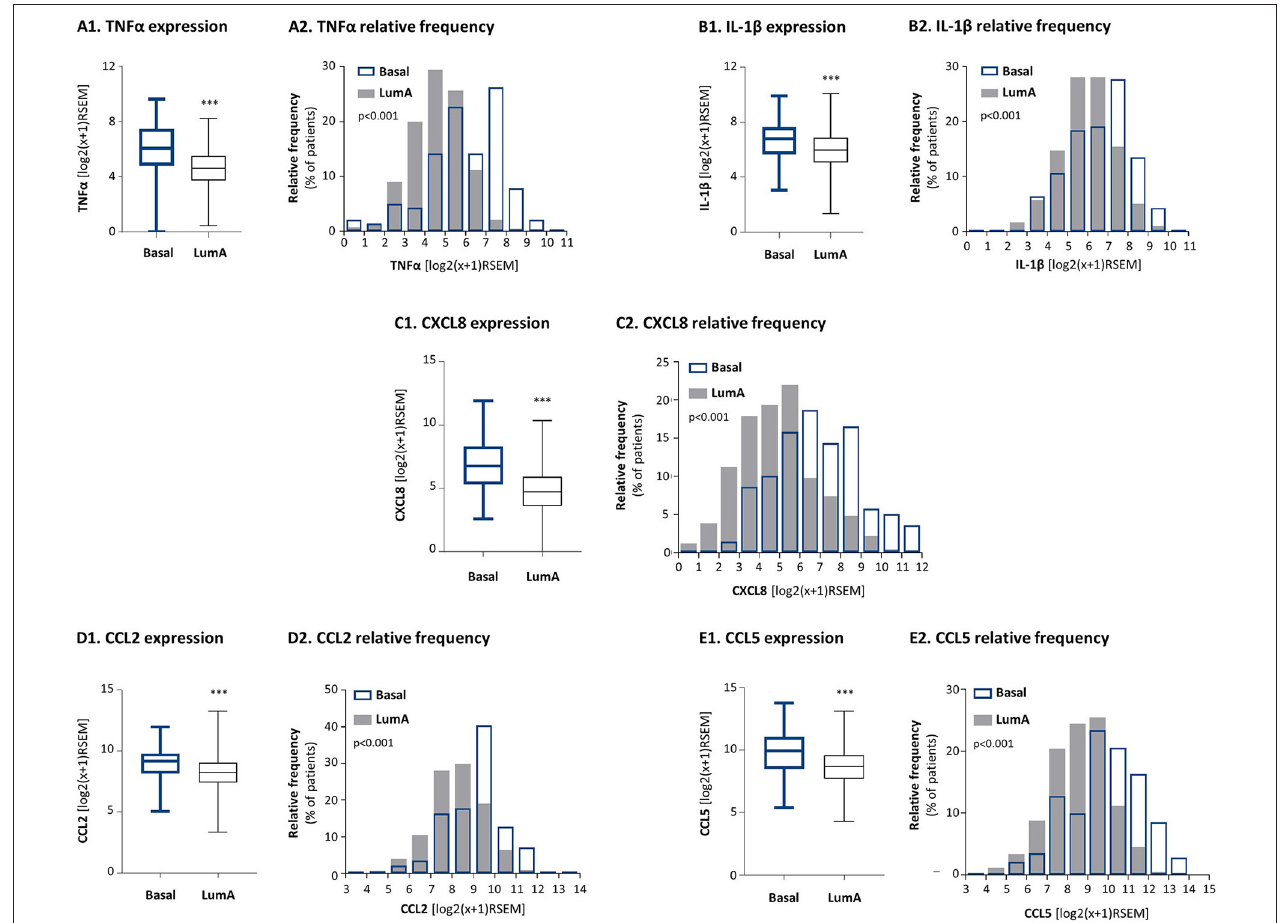
FIGURE 1 | The expression levels of the pro-inflammatory cytokines TNF α and IL-1 β and of their chemokine targets are significantly higher in basal patients than in luminal-A patients. The Figure demonstrates gene expression analyses, performed with the TCGA breast cancer dataset. (A) TNF α , (B) IL-1 β , (C) CXCL8, (D) CCL2, (E) CCL5. (A1–E1) Boxplots comparing expression levels in basal patients and luminal-A patients. *** p < 0.001. (A2–E2) Histograms demonstrating the distribution of expression levels of each of the factors in basal and luminal-A patient tumors. RSEM, RNAseq by